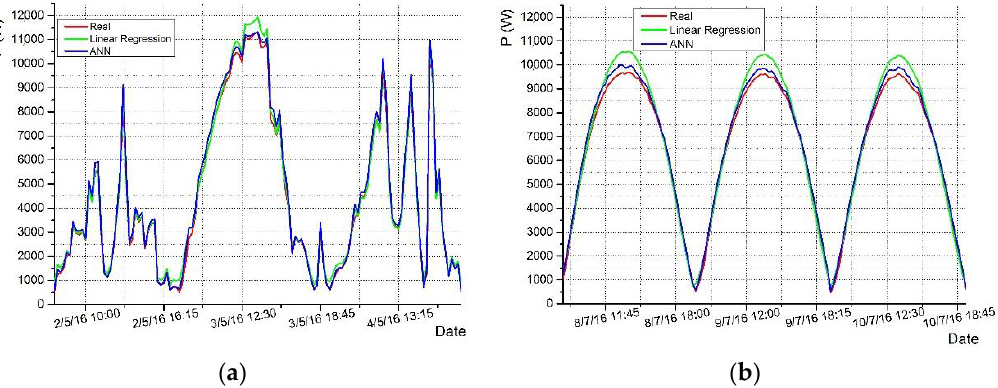
Figure 9. Comparison between actual power output and forecasts of the two alternative methods for three consecutive cloudy ( a ) and three sunny days ( b ), respectively, from 2016.